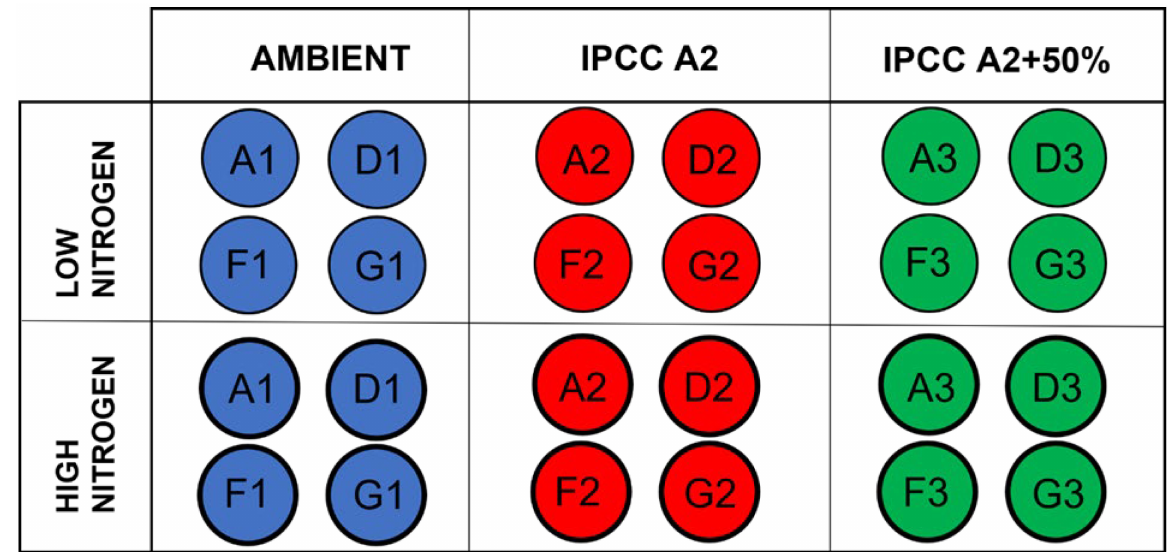
Figure 1. Schematic representation of the experimental design. Regular circles correspond to low nitrogen treatment (N0), and bold circles correspond to high nitrogen treatment (N+). Each tempera- ture treatment has four replicate tanks: ambient temperature (A1, D1, F1, G1), IPCC A2 scenario (A2, D2, F2, G2), IPCC A2 + 50% scenario (A3, D3, F3,